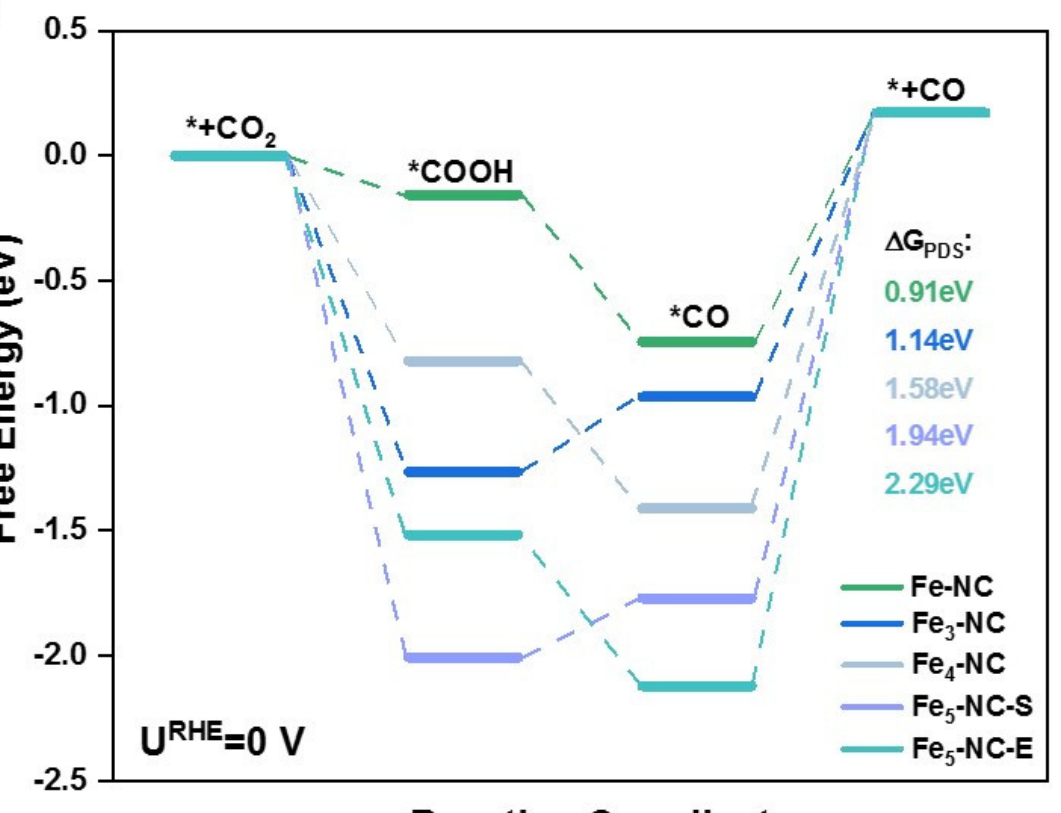
Figure 2. ( a ) The optimized structures of each intermediate during the CO 2 reduction reaction from CO 2 to CO, and ( b ) the Gibbs free energy profiles of CO 2 reduction to CO on Fe n -NC catalysts during CO 2 RR. Table 2. The Bader charge of Co atoms in Co 5 -NC, binding energy ( E b ) between the Co 5 cluster and NC and the cohesive energy ( E c ) of Co atoms in the Co 5